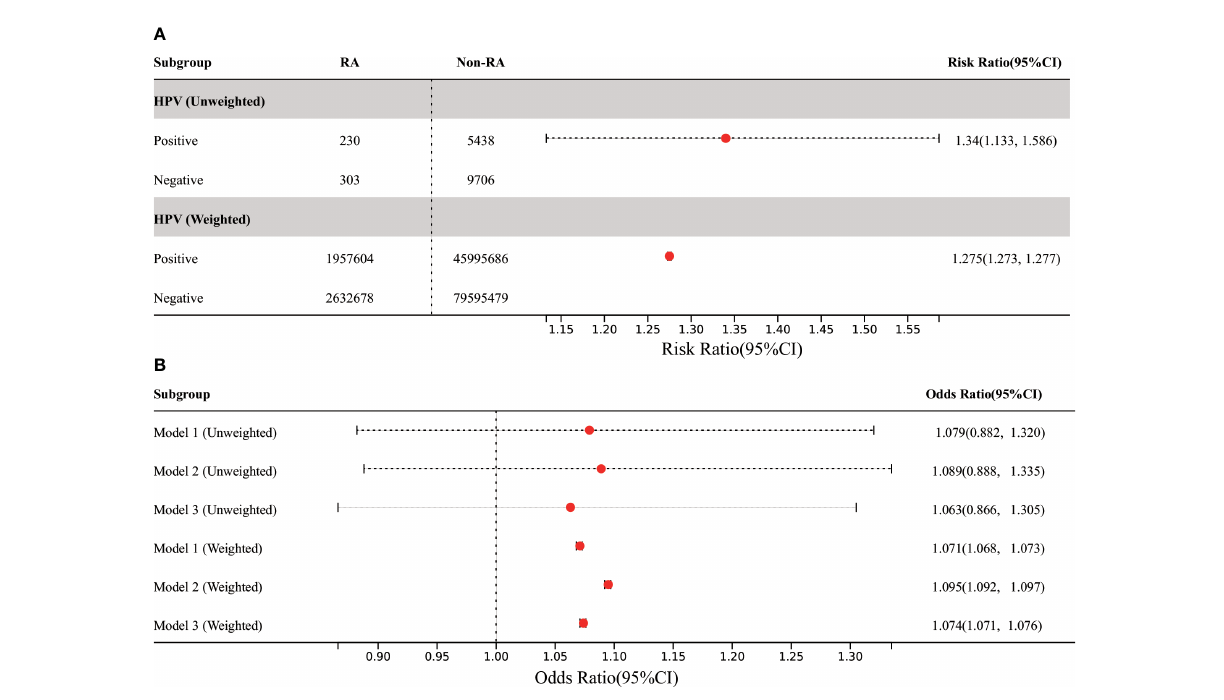
FIGURE 3 Association between HPV infection and RA in US adults. (A) Among all participants, the prevalence of RA in adults was signi fi cantly increased in the HPV-infected group compared with the HPV-uninfected control group. (B) In the three MLR models, the adjusted OR value of HPV infection was positively correlated with RA, but it was only statistically signi fi cant in weighted models. Model 1 was only adjusted for age and gender. Model 2 was adjusted for the confounding covariates with the numerical missing ratio below 5%. Model 3 was further adjusted for all confounding covariates.